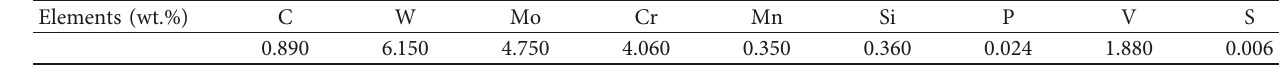
Table 3: Chemical content of M2 steel (by the tool supplier).